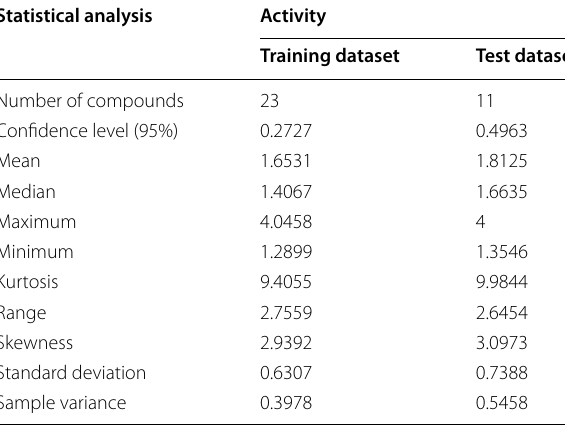
Table 8 Residual values for both training and test dataset